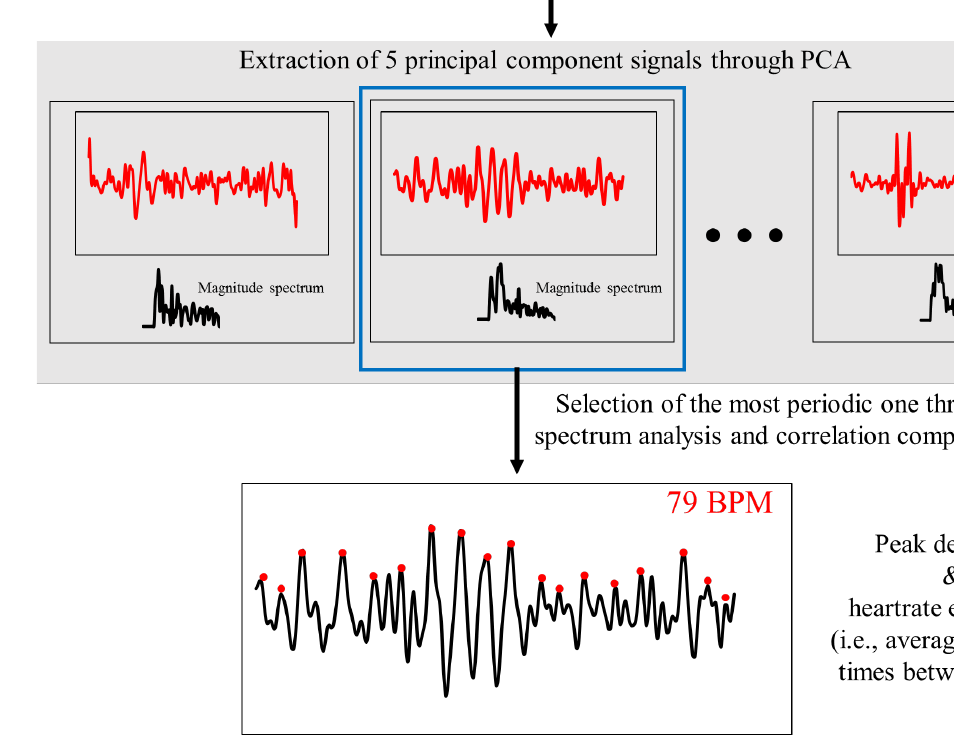
Figure 3. Process flow of the proposed